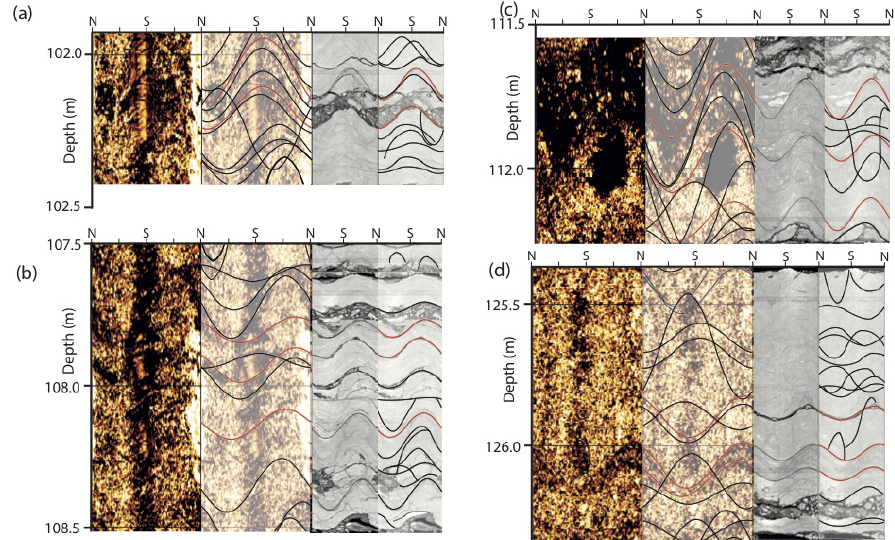
Figure 4. Examples of matching structures between BHTV images and unrolled CT images. In each image, the first two columns are the BHTV amplitude image, without and with interpretations, respectively, whilst the third and fourth columns depict the unrolled CT image over the same interval, also without and with interpretations. Fractures that have been traced in red indicate those that were matched to re-orientated